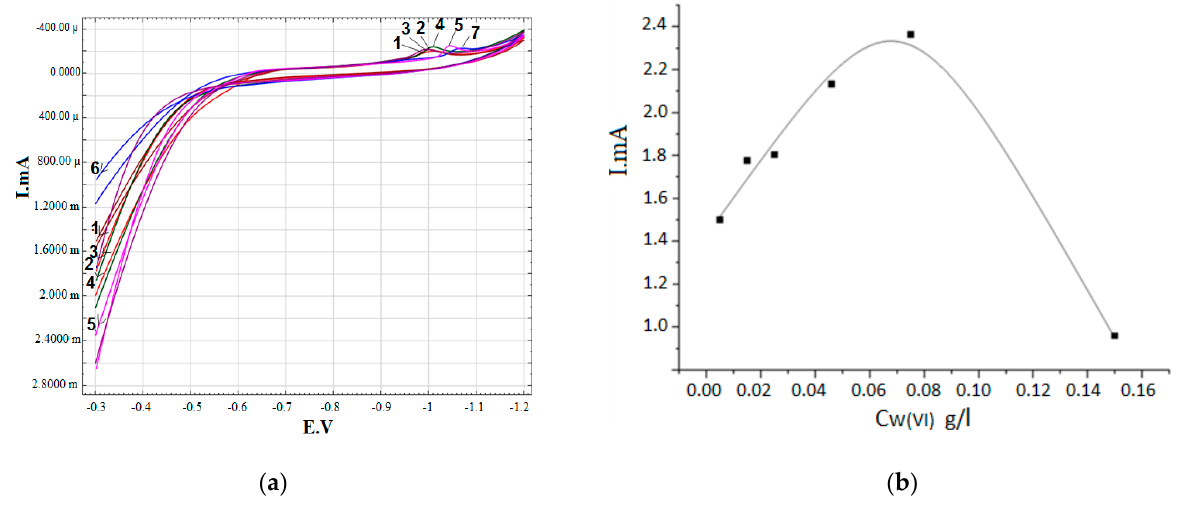
Figure 3. Volt–ampere curves of an iron electrode ( a ) and a change in the ionization current of the iron electrode ( b ) at different concentrations of W(VI). Electrolyte 0.3M Na 2 SO 4 + 0.2 g/L Zr (VI) + W (VI) (g/L): 1—0.005; 2—0.015; 3—0.025; 4—0.05; 5—15.